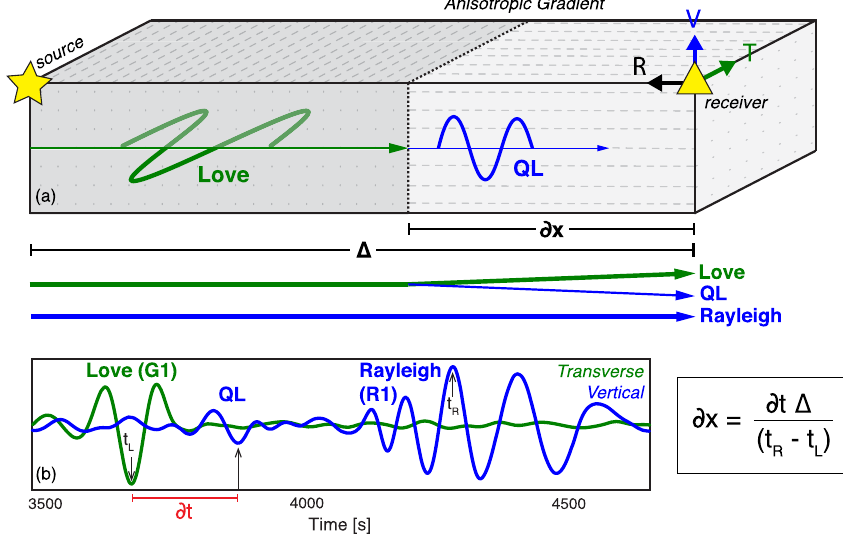
Fig. 1 Process of QL wave scattering due to an anisotropic gradient. a Schematic illustration of a Love wave with transverse (T) particle motion (indicated in green), which upon encountering a lateral gradient in seismic anisotropy, partially converts into a QL wave with the same phase velocity and vertical (V) particle motion (indicated by blue) as a Rayleigh wave. The fundamental Love (G1) and Rayleigh (R1) waves travel a distance Δ between the source and receiver, whereas the QL wave only travels a distance δ x between the scattering location and the receiver. The scattering is caused by a change in strength and/or orientation of the mantle anisotropy, indicated by the grey fabric pattern. b Example recording of a QL wave arrival that is found on the vertical component between G1 and R1. The distance to the scattering point ( δ x) is related to the time delay ( δ t) between the QL and G1 via the equation